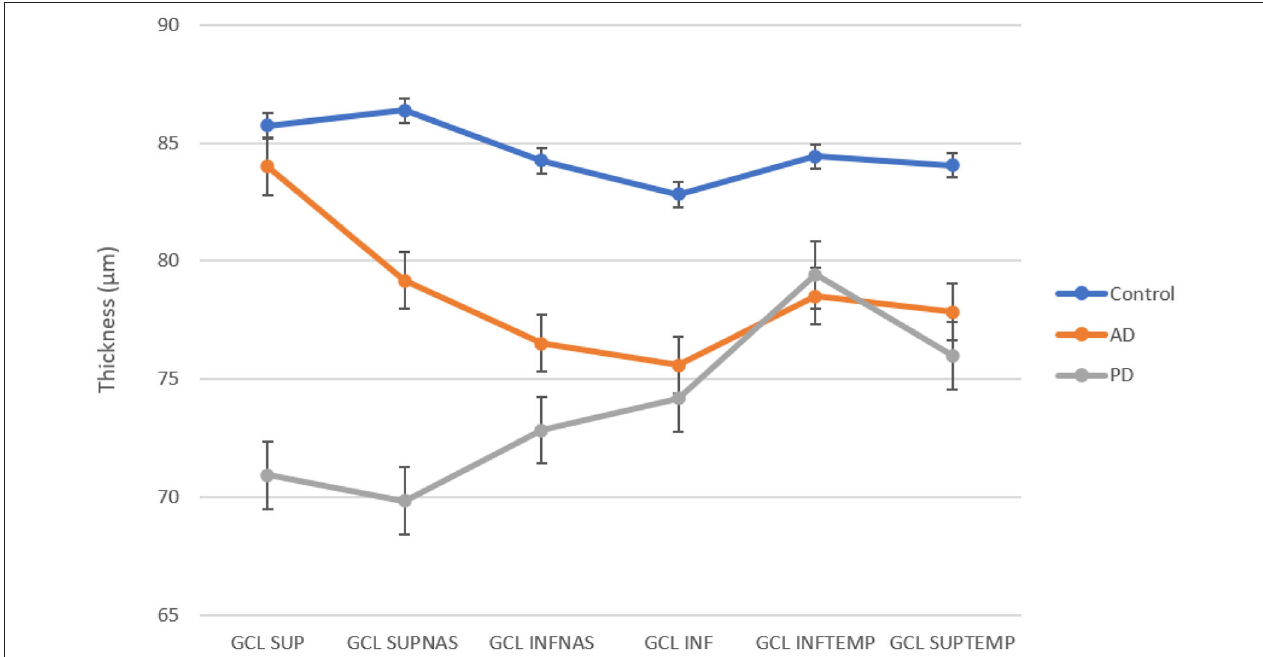
FIGURE 2 | GCL thickness in superior, superiornasal, inferiornasal, inferior, inferiortemporal, and superiortemporal sectors for each group. AD and PD patients show a reduction in all sectors with respect to